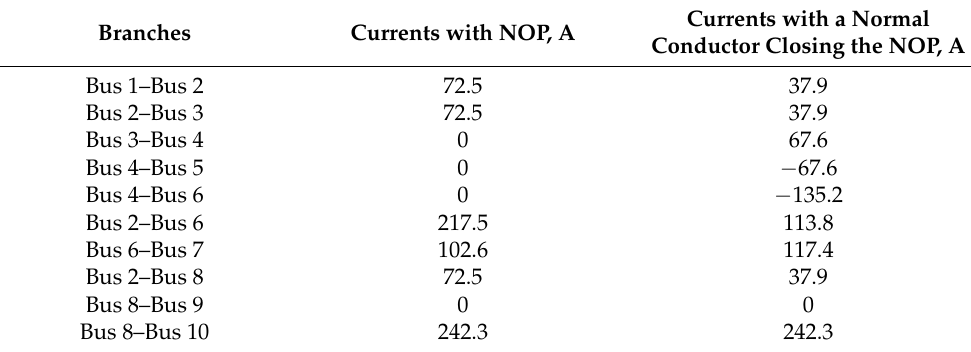
Table 4. Comparison between the performance of the DCSOP and the normal conductor in terms of the change of branch currents.